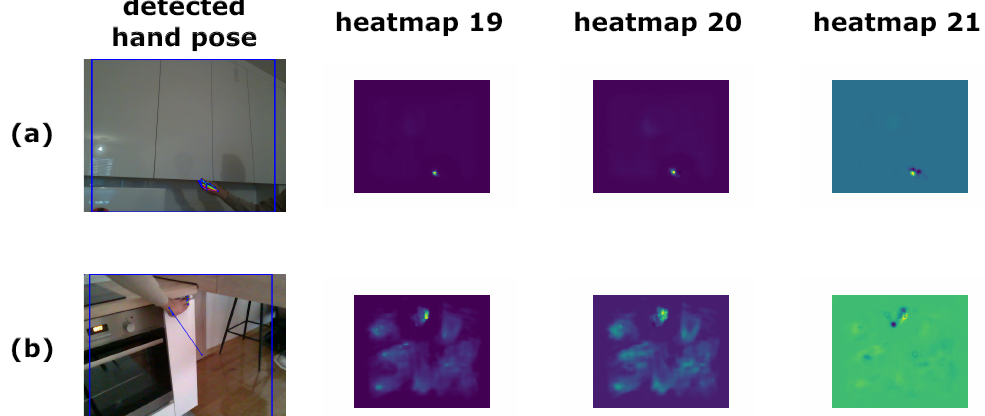
Figure 9. Two examples of results from hand pose detection using OpenPose. In ( a ), a well predicted hand pose is shown, while in ( b ), a poorly predicted hand pose is shown. When the predictions are good, heatmaps #0–20 have well defined keypoints.